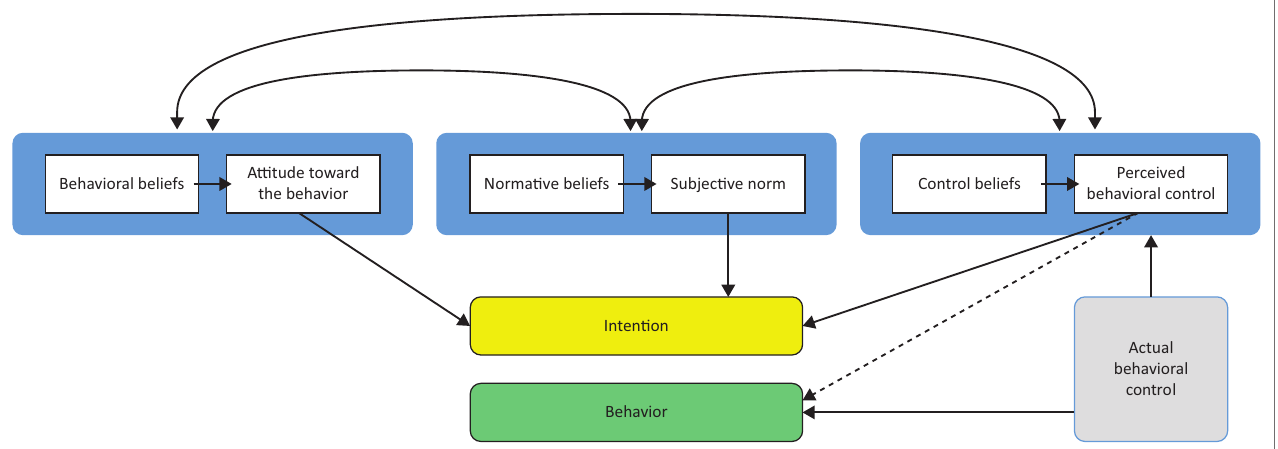
FIGURE 1: Theory of planned